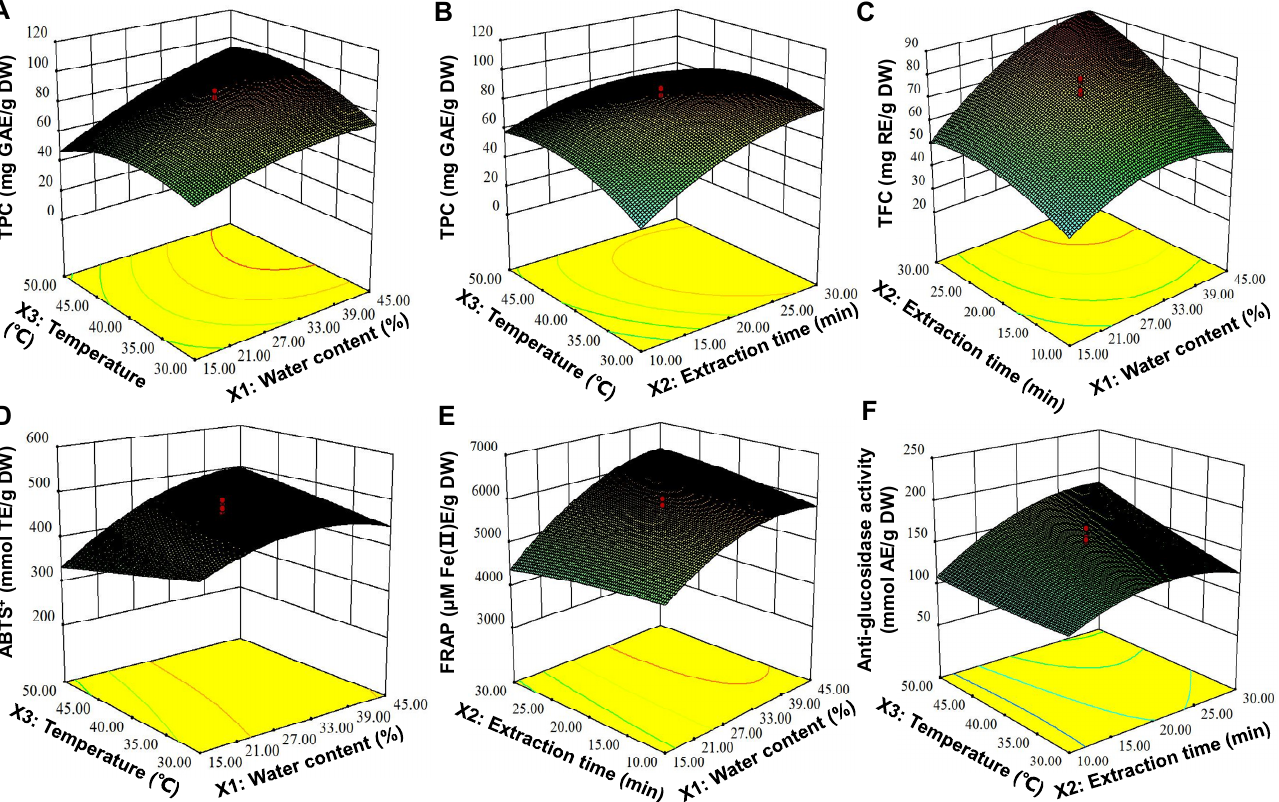
Figure 3. The 3D surface plots of interaction effects between the independent variables on TPC ( A , B ), TFC ( C ), ABTS +• ( D ), FRAP ( E ), and α -GIA ( F ) of the DLT extracts.